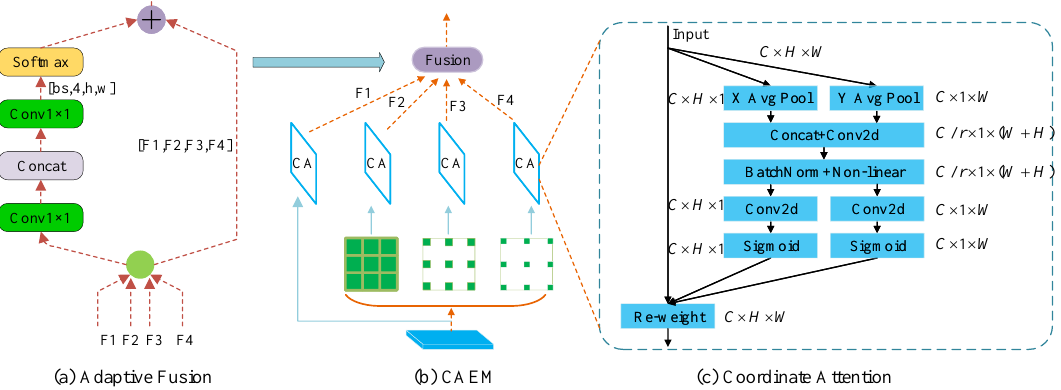
Figure 6. The architecture of CAEM: The feature is processed by the dilated convolution with rates of 1, 3, and 5, respectively. The coordinate attention mechanism improves the attention of target points. The adaptive fusion method is used to fuse the four feature maps with different receptive field